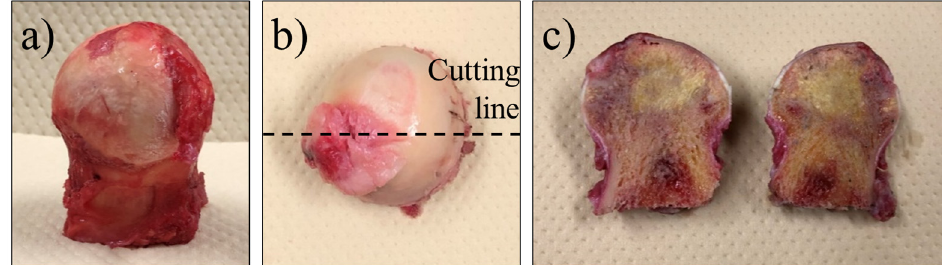
Figure 1. Preparation of the samples: ( a ) an anterior view of the femoral head removed after surgery, ( b ) cutting line, ( c ) front cross-section.